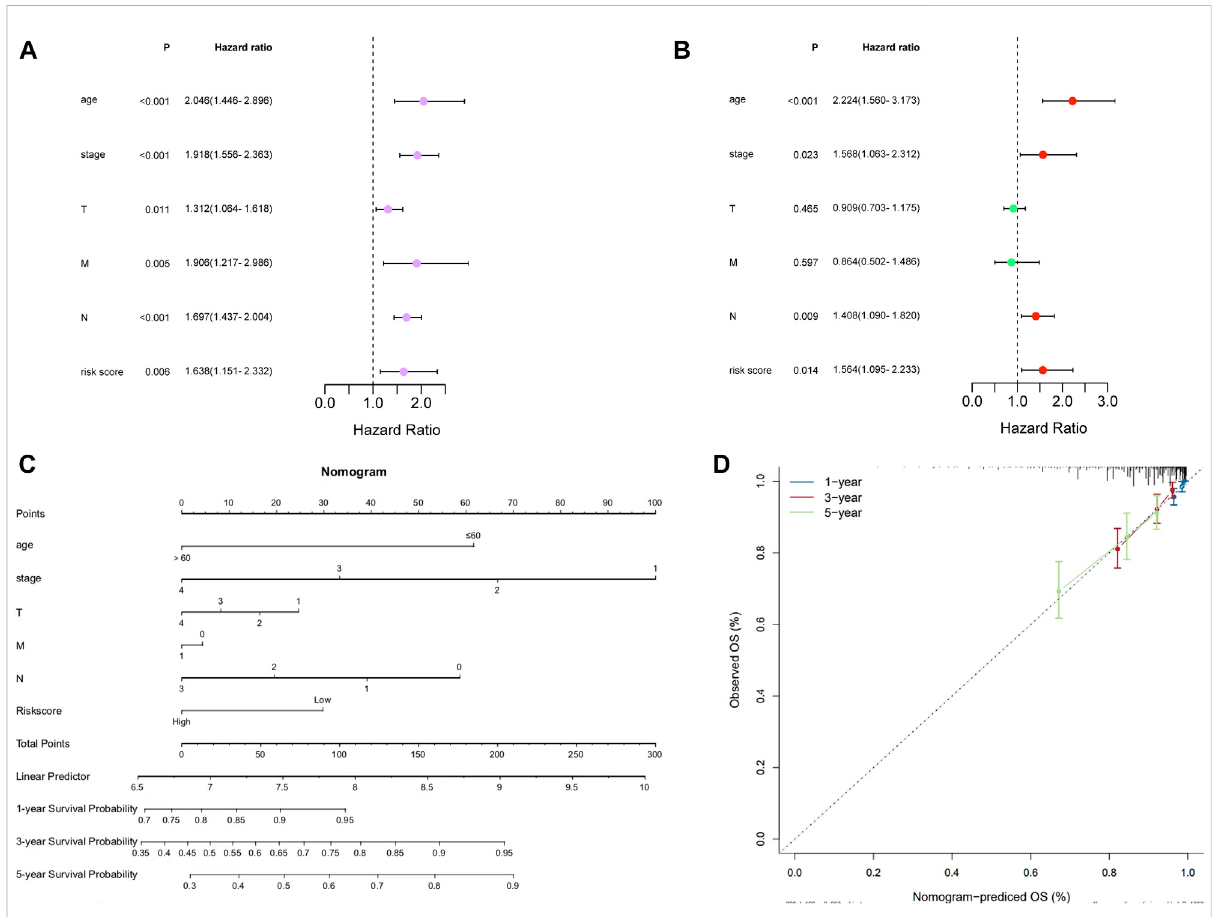
FIGURE 4 Independent prognostic value of the risk model in TCGA cohort. (A) Forest of Univariate analysis. (B) Forest of multivariate analysis. (C) Nomogram to predict the 1-, 3-, and 5-year overall survival rate of BC patients. (D) Calibration curves of the nomogram for 1-, 3-, and 5-year OS